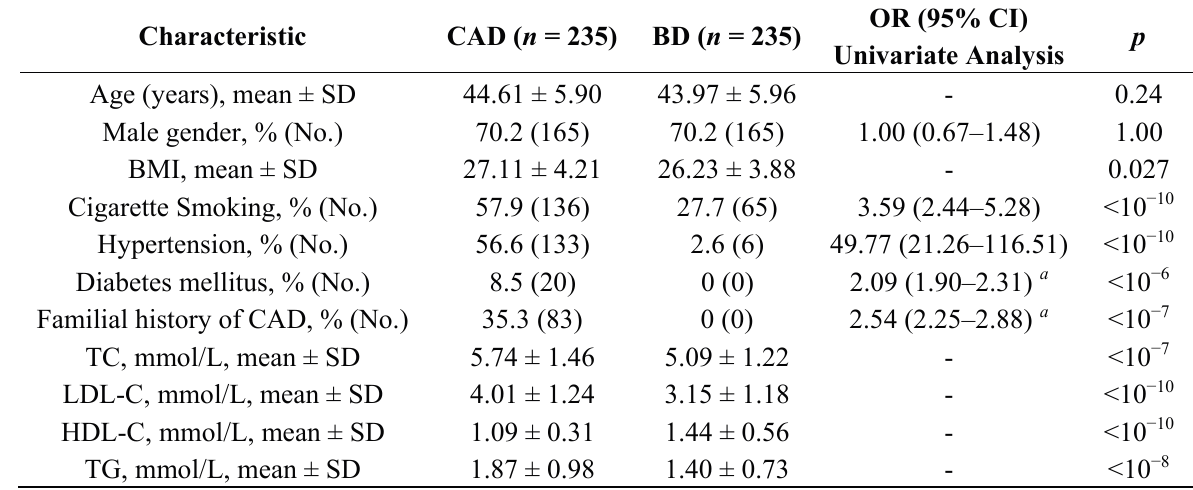
Table 1. Clinical and biochemical characteristics of the coronary artery disease patients and blood